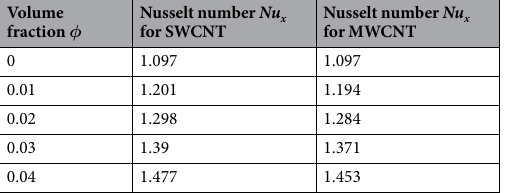
Table 3. Heat transfer rate for different values of volume fraction.